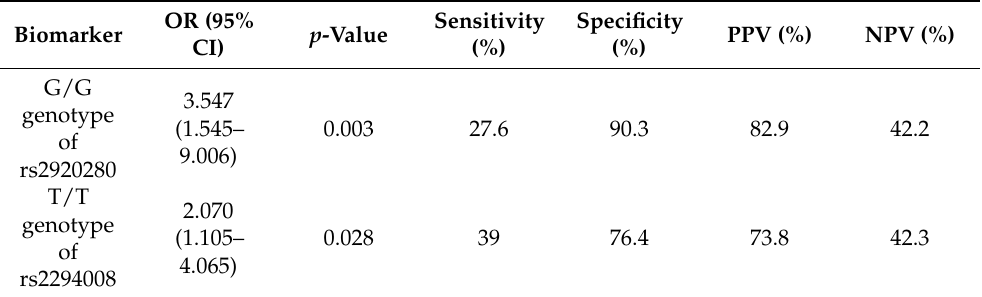
Table 6. Evaluation of a genetic test using the associated tag SNPs as a biomarker for susceptibility to